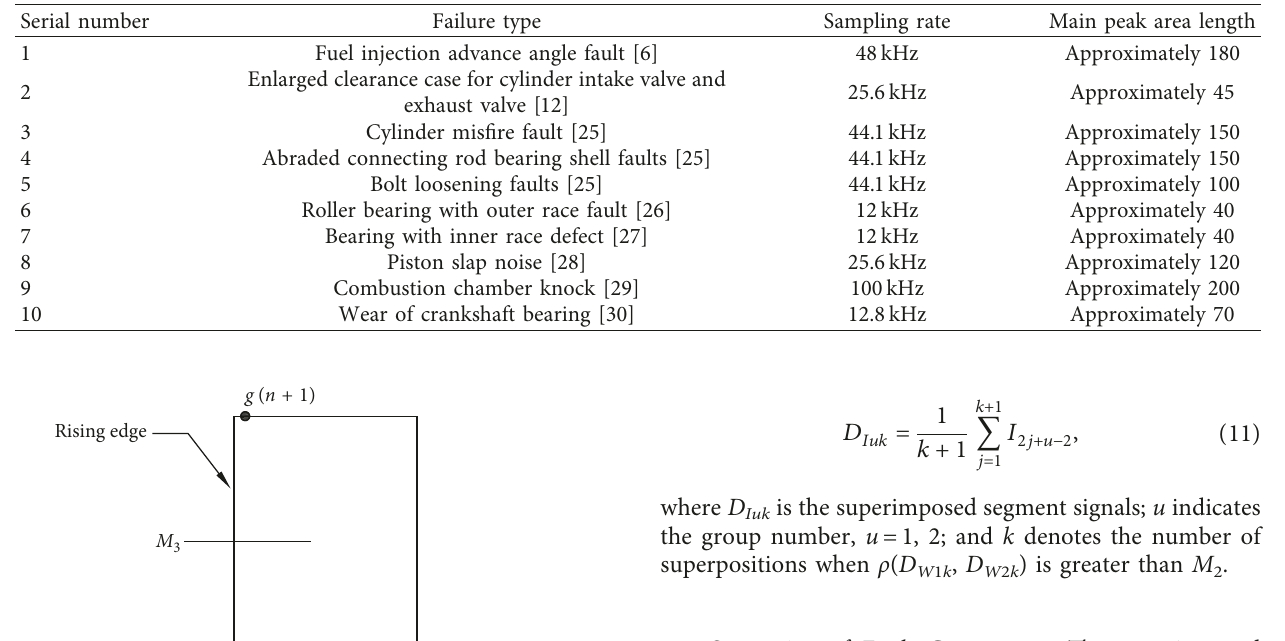
n r + 1 ) corre- ( w points